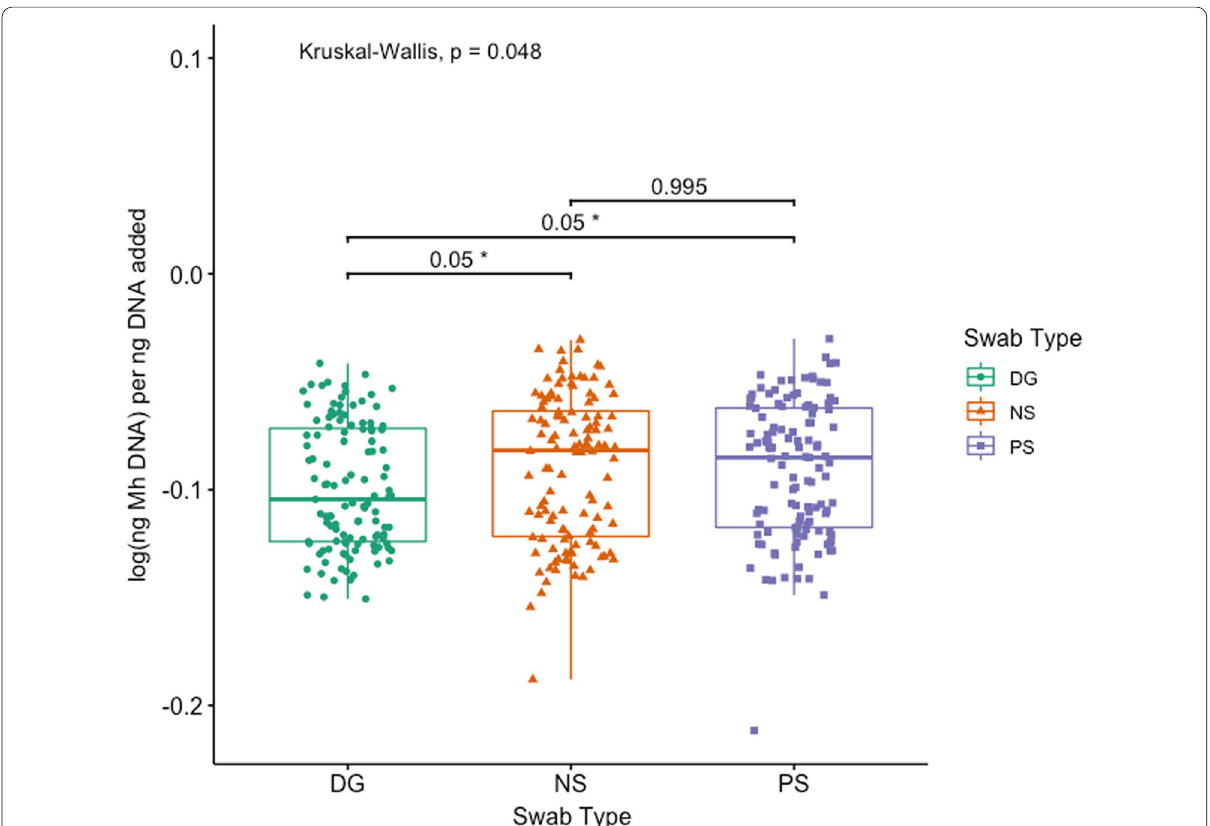
Fig. 2 Box and whisker of log(ng Mh DNA) per ng DNA added vs. swab type. (Kruskal–Wallis test, P < 0.05; *pairwise Dunn test with Benjamini– Hochberg correction, P < 0.05). Key: DG